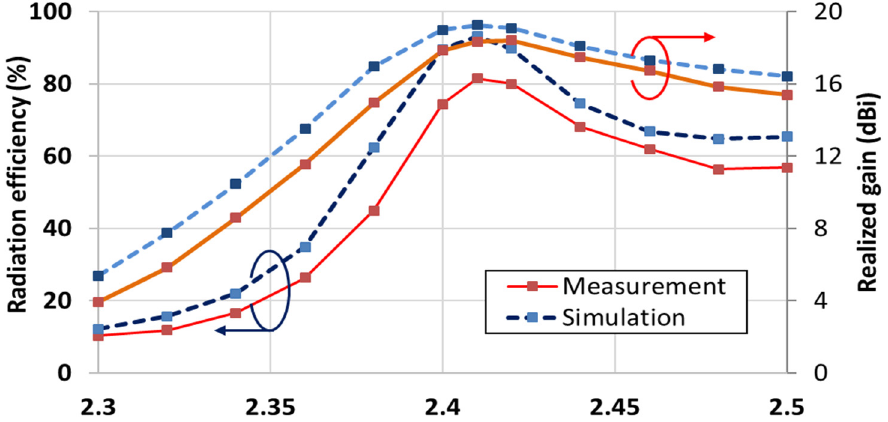
Figure 11. Antenna efficiency and gain comparisons according to frequency.